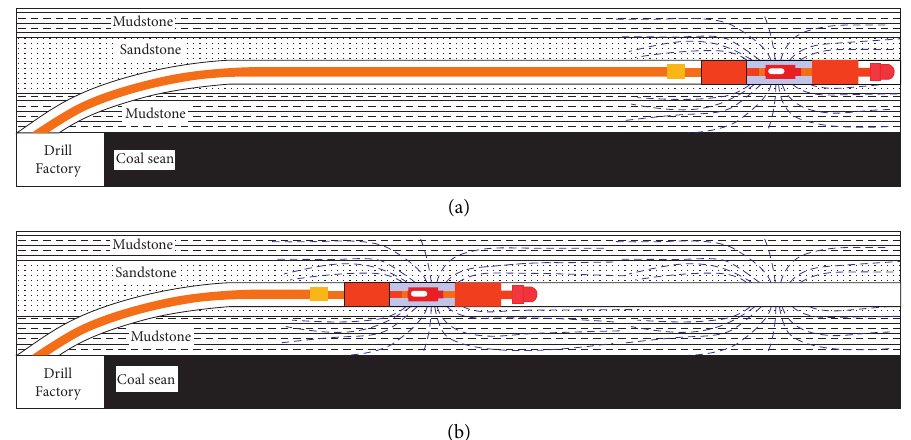
Figure 16: Principle of multipoint drag staging hydraulic fracturing. (a) Multipoint drag staging hydraulic fracturing of the first stage of the fracturing process. (b) The second stage of the multipoint drag hydraulic fracturing process.